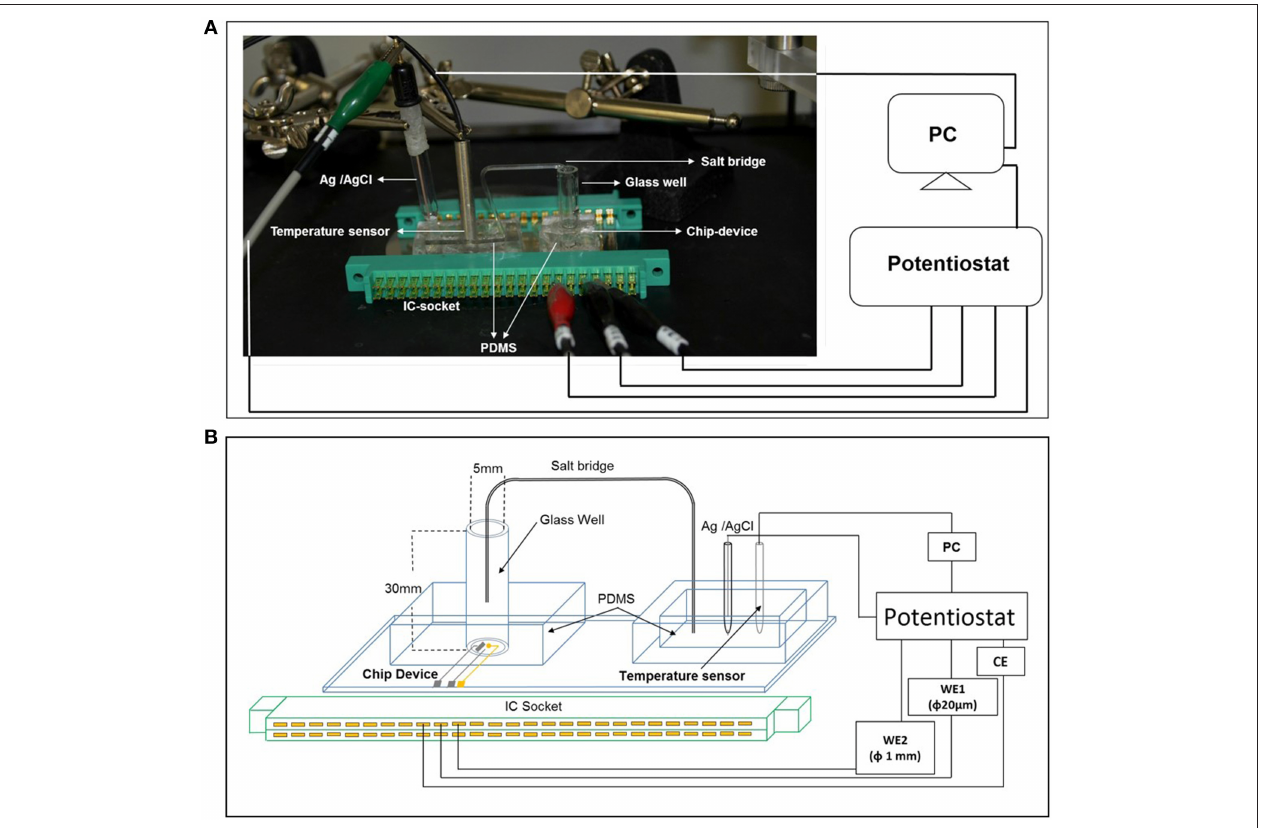
FIGURE 2 | The photograph showing the arrangement of electrodes (A) and the schematic representation of the experimental setup (B) of catalytic amperometry for measurement of oxygen reduction current and reduction current for H 2 O 2 . The setup shows the PDMS prepolymer with a glass tube with an inner and outer diameter of 5 and 7 mm, respectively and height 30 mm containing the chip device; PDMS prepolymer with reference electrode (Ag/AgCl) and the temperature sensor. To avoid any concentration gradient between the 2 wells, a salt bridge was created using a glass tube. Changes in reduction current in WE1 and WE2 were measured using a